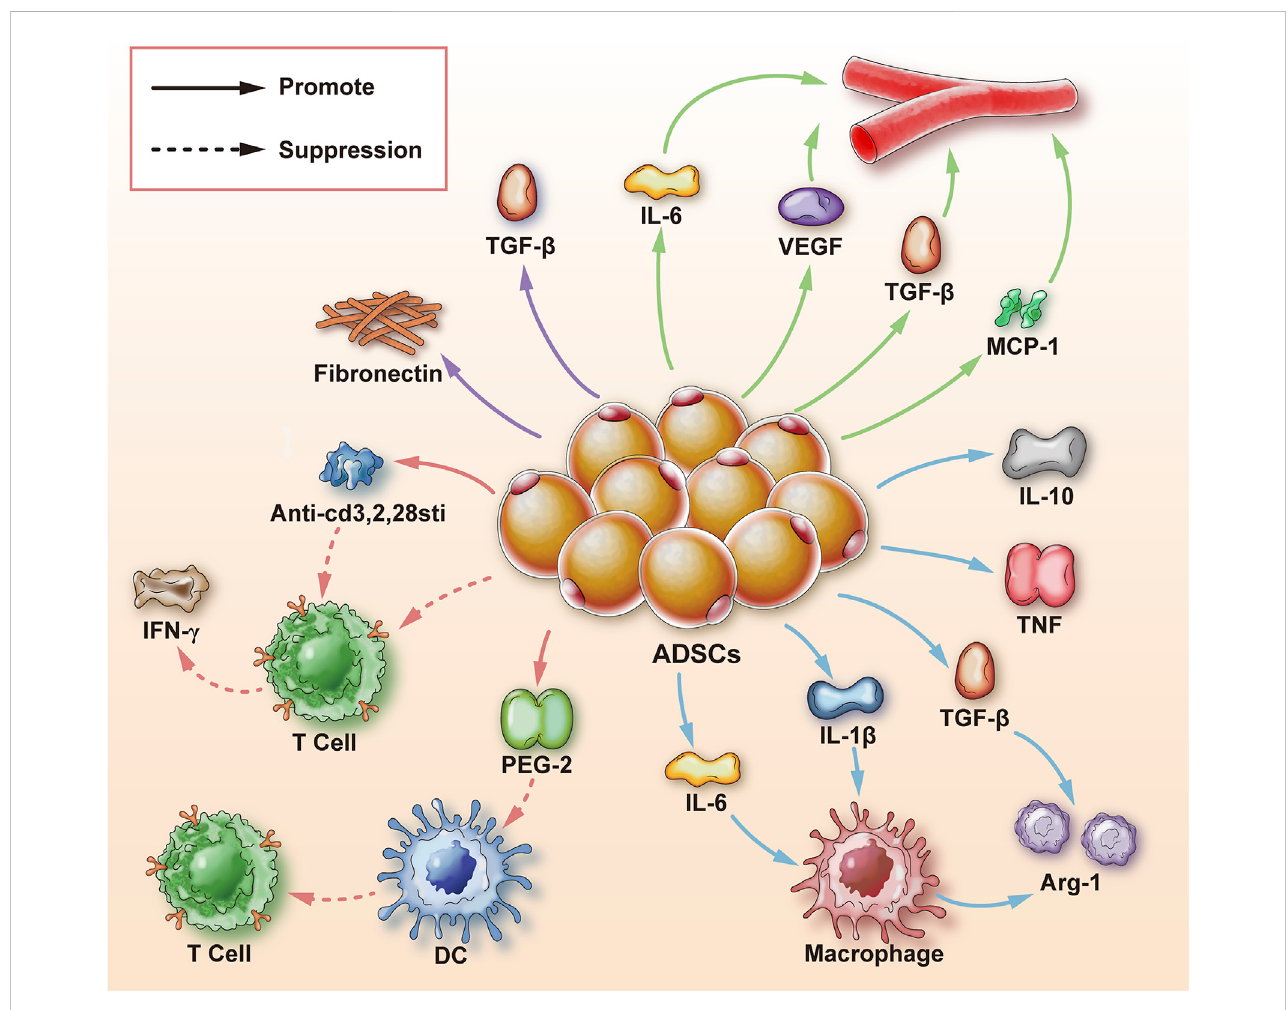
FIGURE 1 Mechanism of adipose-derived stem cells to promote wound healing. ADSCs are adipose-derived stem cells; Arg-1 is arginase-1; TGF- β is transforming growth factor- β ; IL-1 β , 6, 10 is interleukin-1 β , 6, 10; TNF is tumor necrosis factor; MCP-1 is monocyte chemoattractant protein-1; hVEGF is human vascular endothelial growth factor; T cell is T cell; DC is dendritic cell; PGE-2 is prostaglandin-2; IFN- γ is Interferon γ ; Anti-cd3, 2, 28sti are anti-CD3, CD2, CD28 stimulators; fi bronectin generally refers to fi bronectin; solid arrows represent promotion; dashed arrows represent